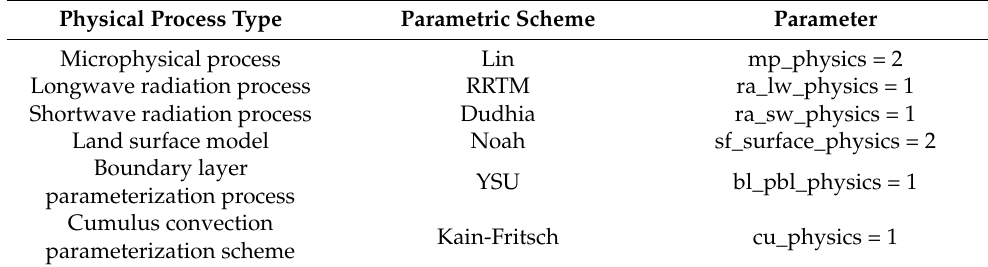
Table 1. WRF physical parameterization